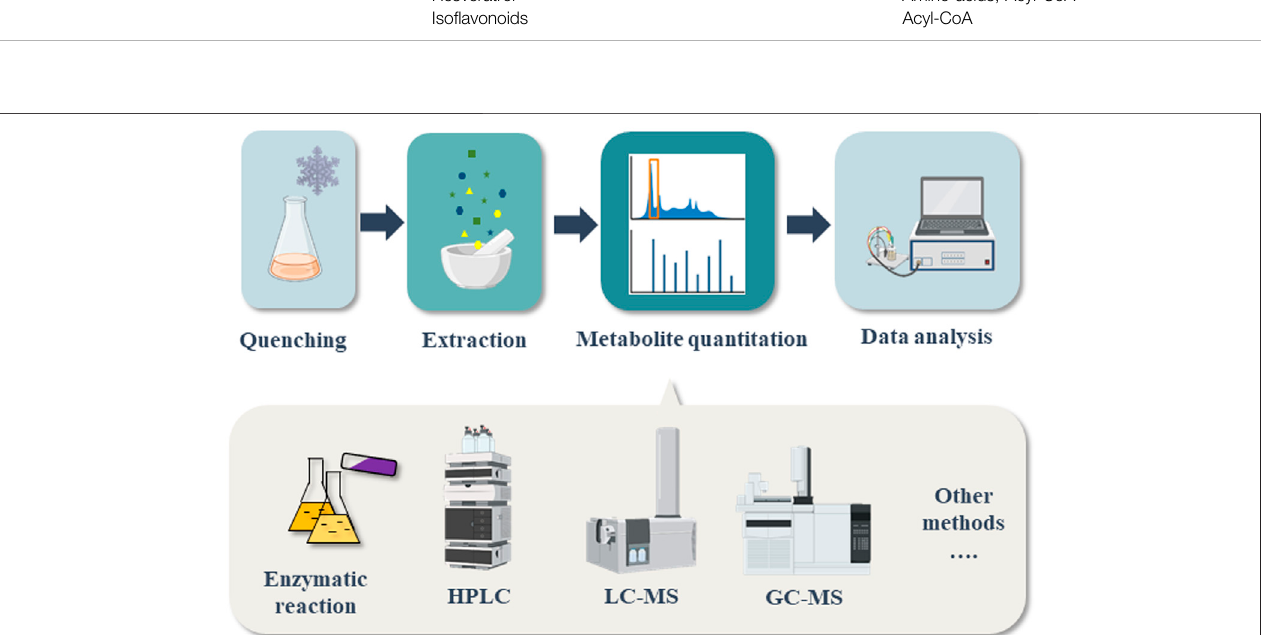
FIGURE 2 | Flow chart of precursor determination process for biosynthetic foods.